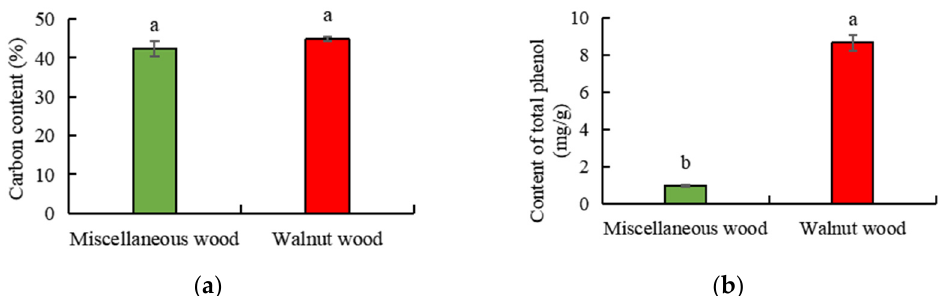
Figure 1. Comparison of ( a ) carbon content and ( b ) total phenol content of walnut and miscellaneous sawdust. Different lowercase letters within each column are significantly different at p < 0.05 be- tween treatments. Table 1. Nutritional mineral element content in walnut sawdust and miscellaneous sawdust.